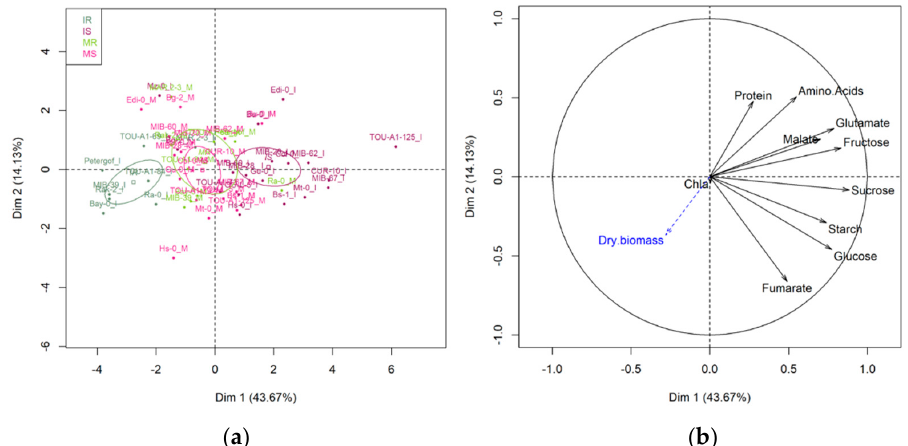
Figure 3. Principal component analysis (PCA) performed on 26 A. thaliana accessions with 10 primary metabolic traits measured at 13 dai on mock-inoculated plants and TuMV-inoculated plants in the ‘2015’ field experiment. ( a ) Score plot of individuals. Score plots of resistant accessions are in green, light green for mock-inoculated, dark green for TuMV-inoculated. Score plots of susceptible accessions are in pink, light pink for mock-inoculated, dark pink for TuMV-inoculated. The confidence ellipses around the centroid of individuals are represented. ( b ) Variable correlation graph. Dry biomass was considered as explanatory traits (in blue on the variable factor map). Chla = Chlorophyll a.